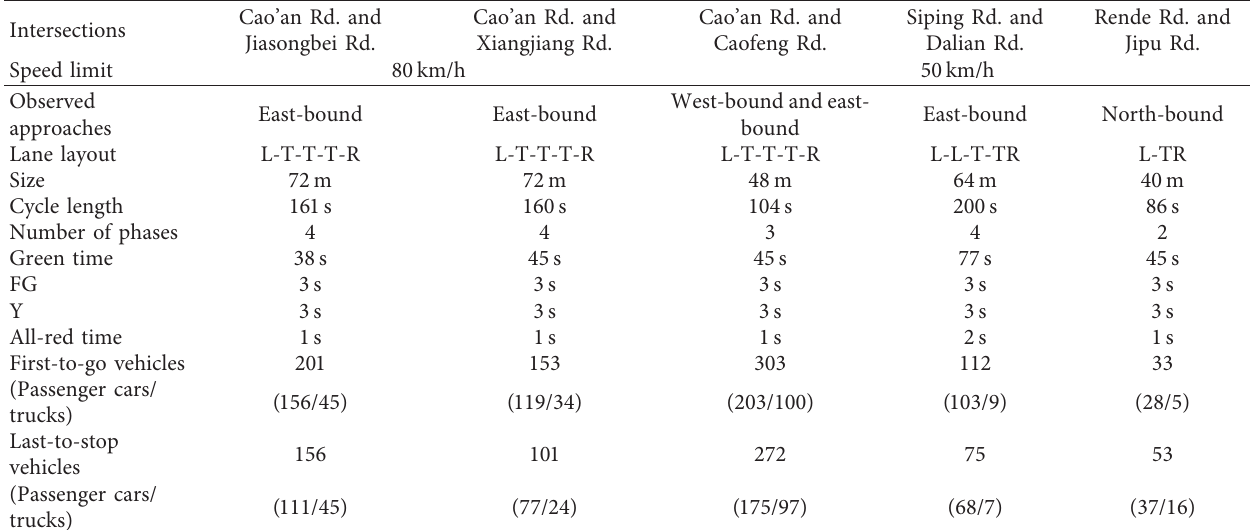
Table 1: Characteristics and conditions of the investigated